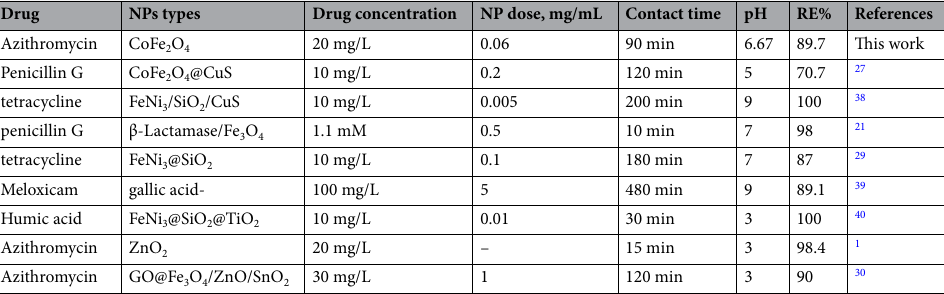
Table 5. The removal of drug compounds by photocatalytic methods under optimal conditions using various catalysts.